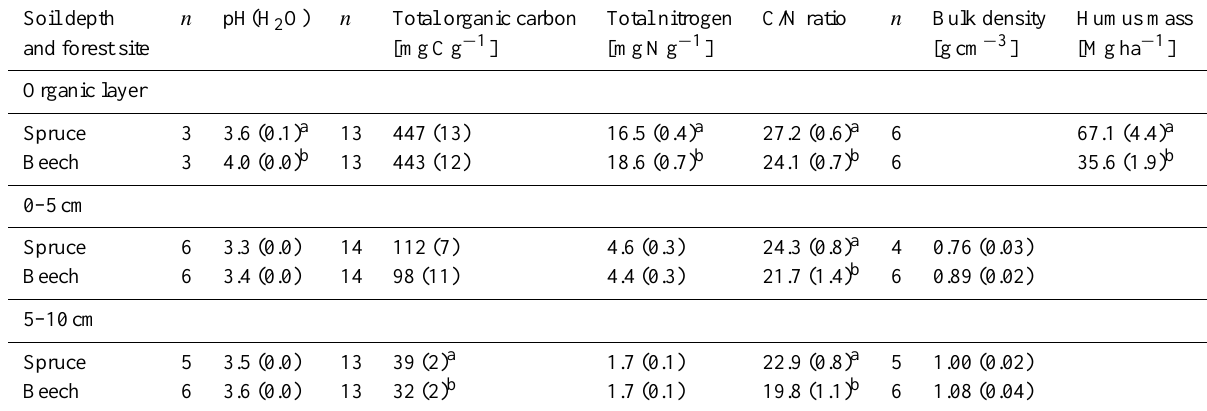
Table 1. Soil characteristics of the spruce and beech stands at the Solling